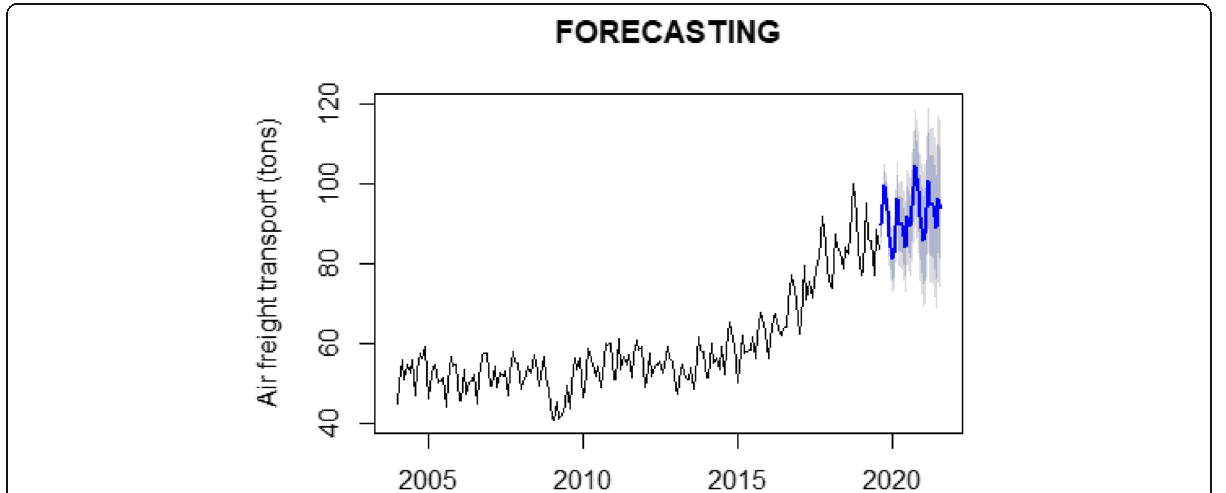
Fig. 2 The movement of goods (in tons) transported by air between January 2004 and August